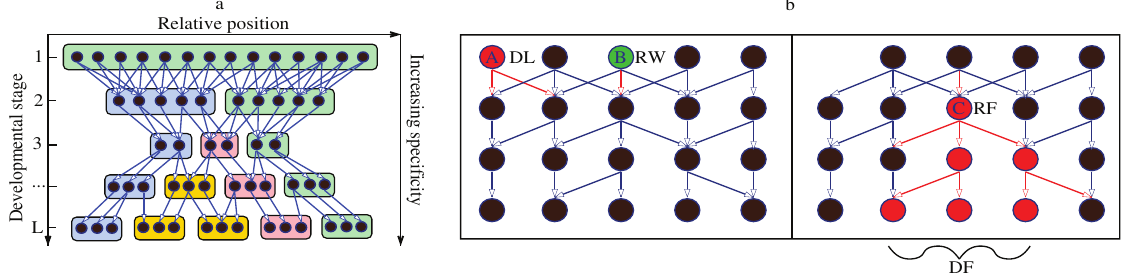
Figure 1. An abstract DGEN. ( A ) The circles denote state-transitioning genes, edges represent directed regulatory interactions, and colored boxes refer to spatial domains that form during development. If regulatory genes become increasingly function-specific as development progresses, the network gradually becomes sparser in that direction. ( B ) Evolutionary perturbations on a DGEN’s structure: Gene A is deleted (DL), while gene B is rewired (RW) losing an outgoing edge. This RW event causes the regulatory failure (RF) of gene C, which then causes a cascade of five more RF events. This cascade causes developmental failure (DF). Note that the removal of some upstream regulators does not always cause an RF event (e.g., genes regulated by